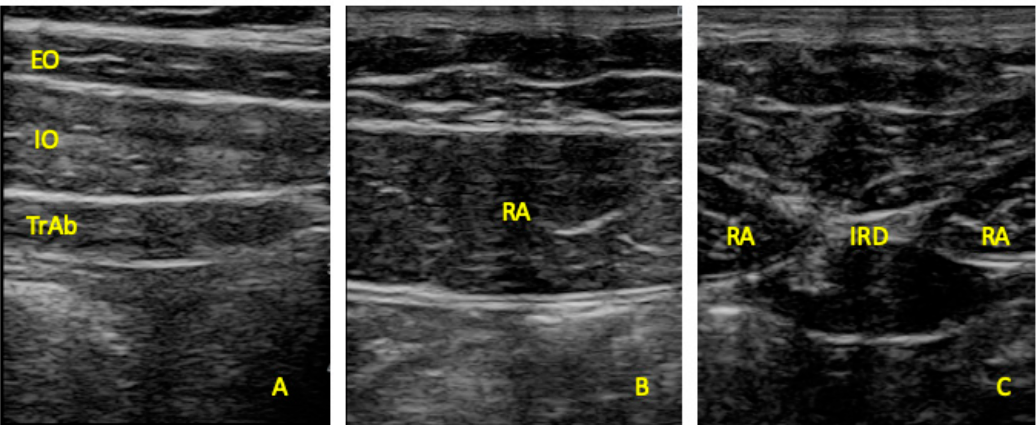
Figure 1. Ultrasound imaging thickness for the EO, IO, TrAb ( A ), RA thickness ( B ) muscles, and IRD ( C ). EO, external oblique; IO, internal oblique; TrAb, transversus abdominis; RA, rectus abdominis; IRD, inter-recti distance.